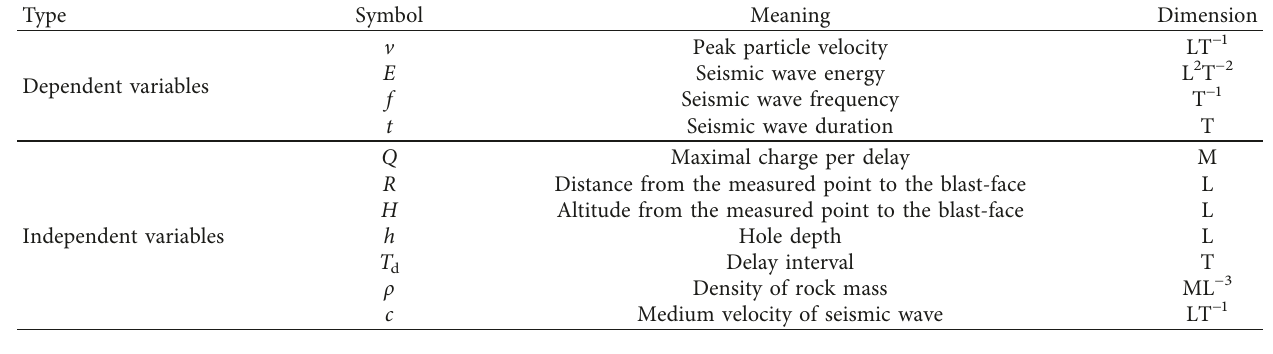
Table 2: Major influential